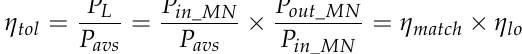
where η loss is the MN’s transmission efficiency, which equals 1 in the absence of the MN. The matching efficiency η match can be further derived as Equation (26), which equals 1 in the case of conjugate matching, where Z S = R S + j X S is the source impedance and Z in = R in + j X in is the input impedance of the MN with a load attached. Table 3 details the simulated η match and η loss for all MNs in the range of 23–31 GHz, and their product η tol is plotted in Figure 19. These findings validate the effectiveness of the filter synthesis theory in creating broadband MNs and explicitly reflect the design focus of each MN. The OMN scores well among various efficiency indicators, where the in-band η tol surpasses 77.2% and fluctuates no more than 5.4%, ensuring a smooth and low-loss power transfer. As for the ISMN, η match shows a more prominent trend of increasing with frequency than η loss , with the difference between the highest and lowest fundamental frequencies of η match being up to 27.2%, which represents the broadband strategy implemented by the ISMN to better match at the high- frequency side and introduce a proper low-frequency mismatch to cope with the de- manded driving power of the output stage growing with frequency. In addition, η loss re- mains above 59.2%, so the adverse impact of the associated IL on gain and PAE is still tolerable. Thanks to the applied band-pass filter structure, the IMN manifests superior and nearly uniform η match . Nonetheless, we intentionally sacrifice η loss to attain an eventual broadband gain response with enhanced stability in return for losing more than half of the transmitted signal energy, which seldom compromises large-signal performance. Overall, they exhibit a gradient decreasing η tol from the OMN to the IMN, with peaks lying in the upper-frequency portion (28–30 GHz).